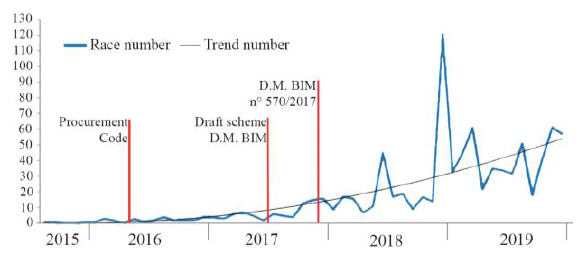
Figure 1. BIM tenders trend monitoring (OICE 2019) In terms of value, the BIM tenders raised 296.3 million euros against the 1,502 million of the entire engineering and architecture services market and represent 19.7% of the tenders